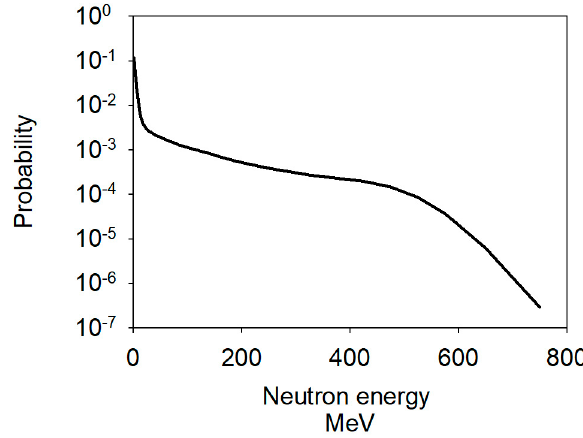
Figure 1. The Los Alamos Neutron Science Center (LANSCE) broad band neutron spectrum used in this study [8].